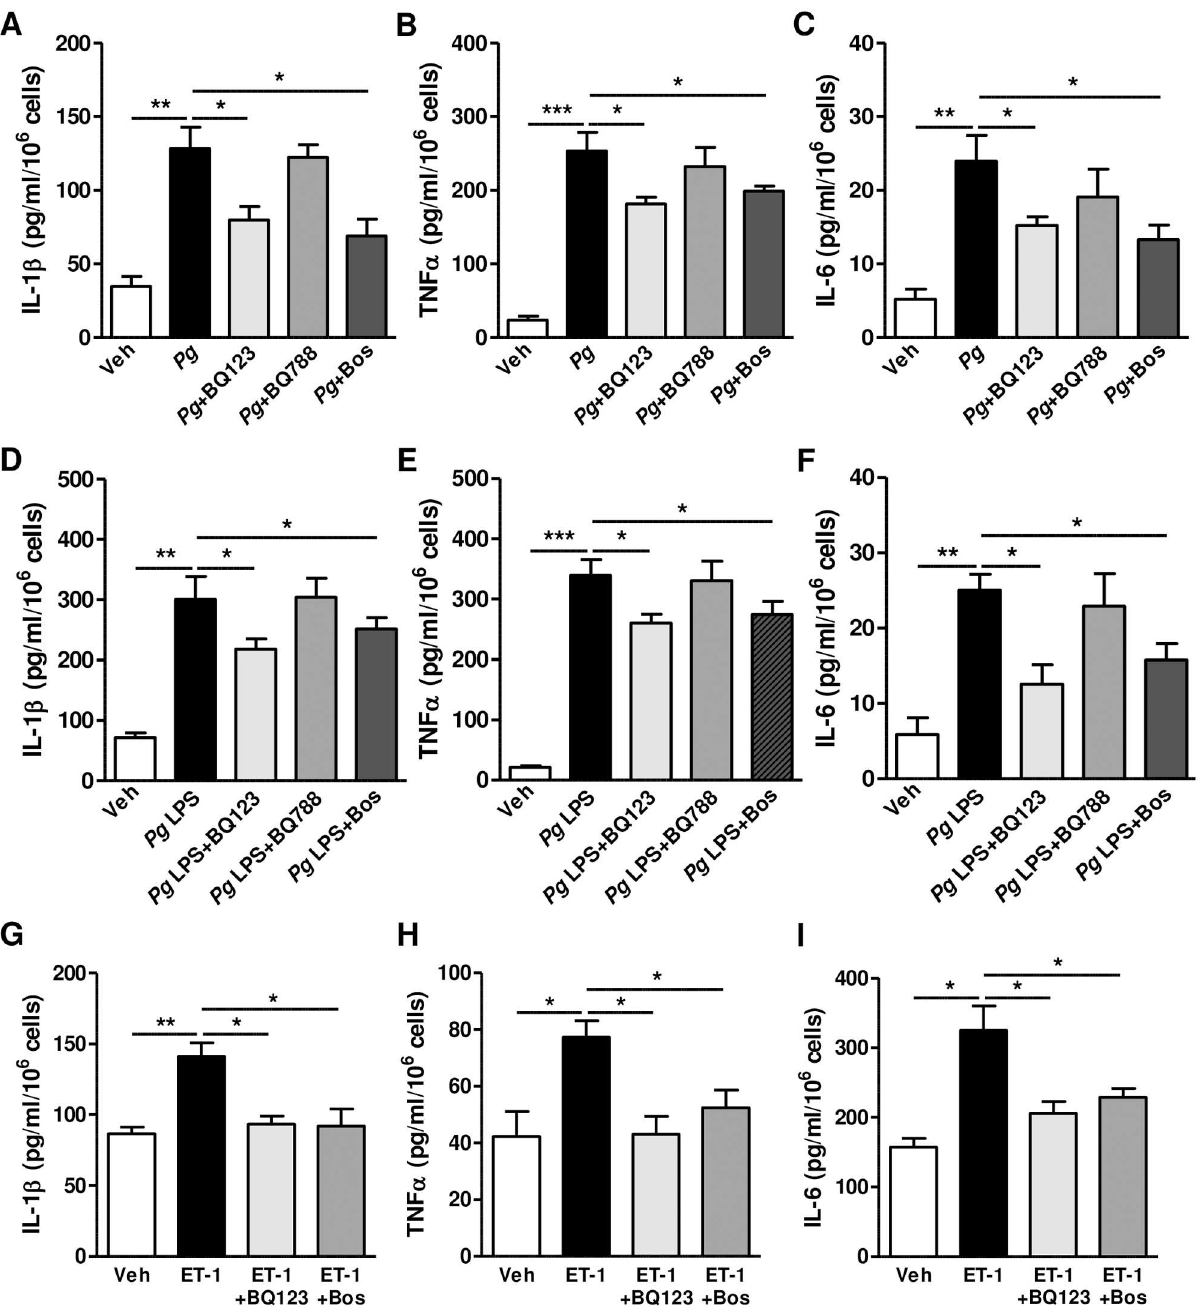
Fig 2. Effect of endothelin inhibitors on the production of inflammatory cytokines in HGECs. (A to C) Reduced productionof IL-1 β (A), TNF α (B), and IL-6 (C) after treatment with endothelin receptorantagonists and P . gingivalis . After treatment with BQ123 (100 nM), BQ788 (100 nM), or bosentan(100 nM) for 1h, cells were infected with P . gingivalis (100 MOI) for 24h. (D to F) Reducedproductionof IL-1 β (D), TNF α (E), and IL-6 (F) after treatment with endothelinreceptor antagonists and P . gingivalis LPS (1 μ g/ml). After treatment with BQ123 (100 nM), BQ788 (100 nM), or bosentan(100 nM) for 1h, cells were treated with P . gingivalis LPS (1 μ g/ml) for 24h. (G to I) Reduced productionof IL-1 β (G), TNF α (H), and IL-6 (I) after treatment with endothelinreceptorantagonistsand ET-1. After pre-treatment with BQ123 (100 nM), BQ788 (100 nM), and bosentan(100 nM) for 1h, cells were treated with ET-1 (100 nM) for 24h. Secretion of cytokines or ET-1 was examinedby ELISA in the culture supernatants from five samples(sample #1–5). * P < 0.05; ** P < 0.01; *** P <